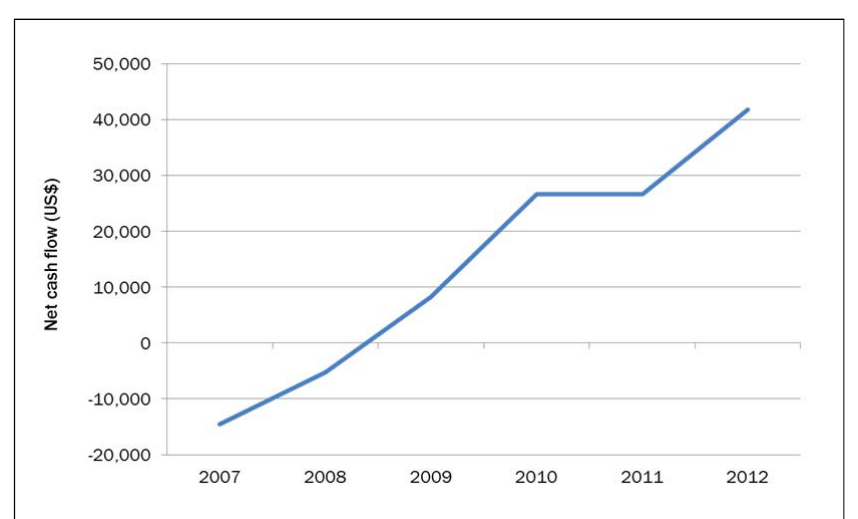
Figure 10. Farm Annual Net Cash Flow (US$), 2007–2012